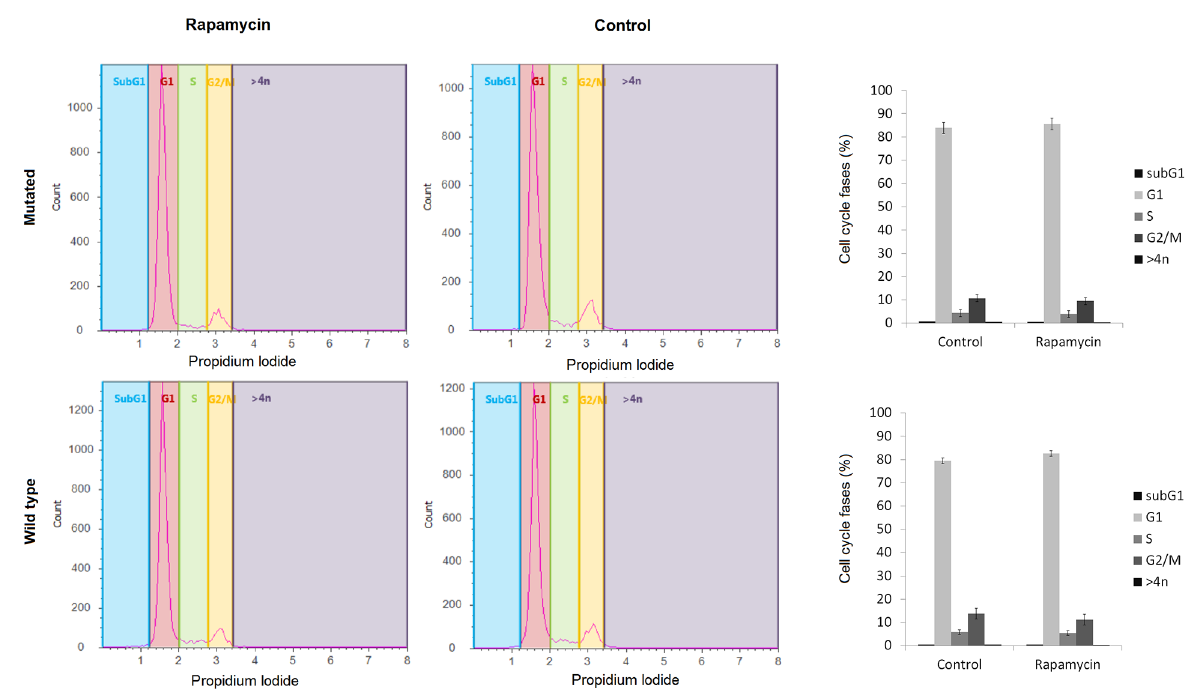
Figure 2 ‒ Cell cycle analyses. Cells were lysed, stained in a hypotonic stain buffer containing propidium iodide and submitted to Attune Cytometer cell cycle analysis. The quantification of the different cell cycle phases in a representative mutated and WT samples is shown in the left panel. The average percentage of cells in each cell cycle phase in mutated and WT cells is shown on the right.